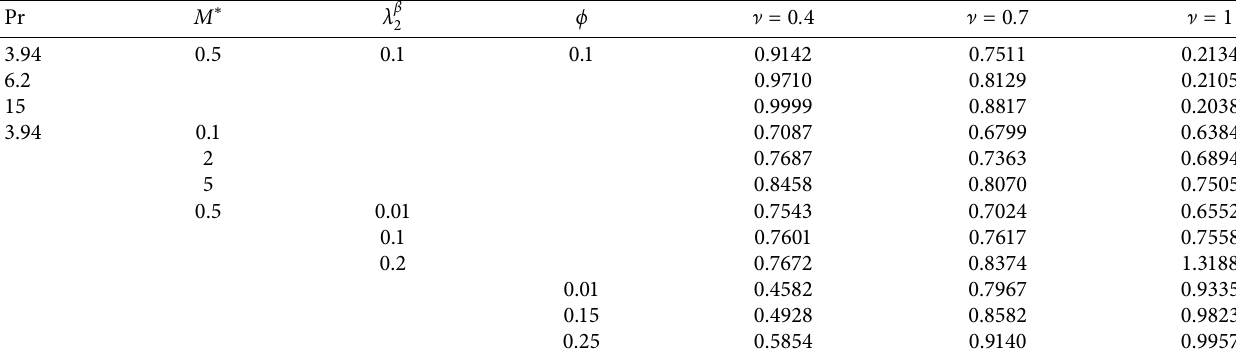
� 0 . 5 ,M � 10 , Gr � 5 , and Re � 1